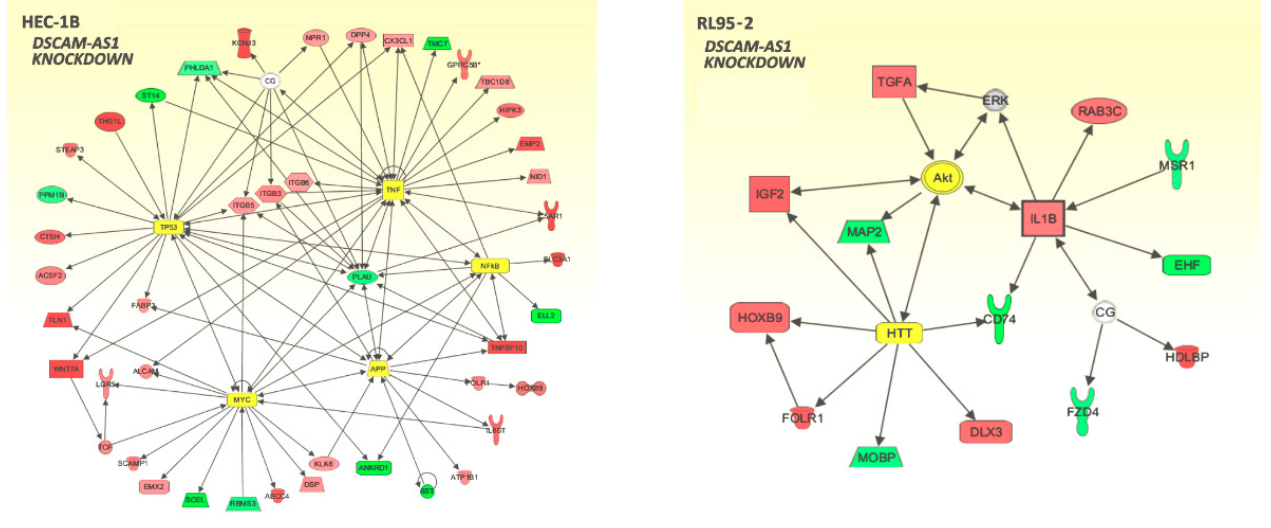
Figure 5. Networks of genes regulated upon silencing of DSCAM-AS1 in HEC-1B and RL95-2 cells as assessed by Affymetrix GeneChip and subsequent pathway analyses using Ingenuity Pathway Analysis (IPA) software (Qiagen Bioinformatics). Knockdown was less efficient in RL95-2 cells due to its positive ER α status (see Discussion section). The gene networks of upregulated genes (red) and downregulated genes (green) also indicate their key upstream regulators (yellow). Solid arrows: affecting gene expression.